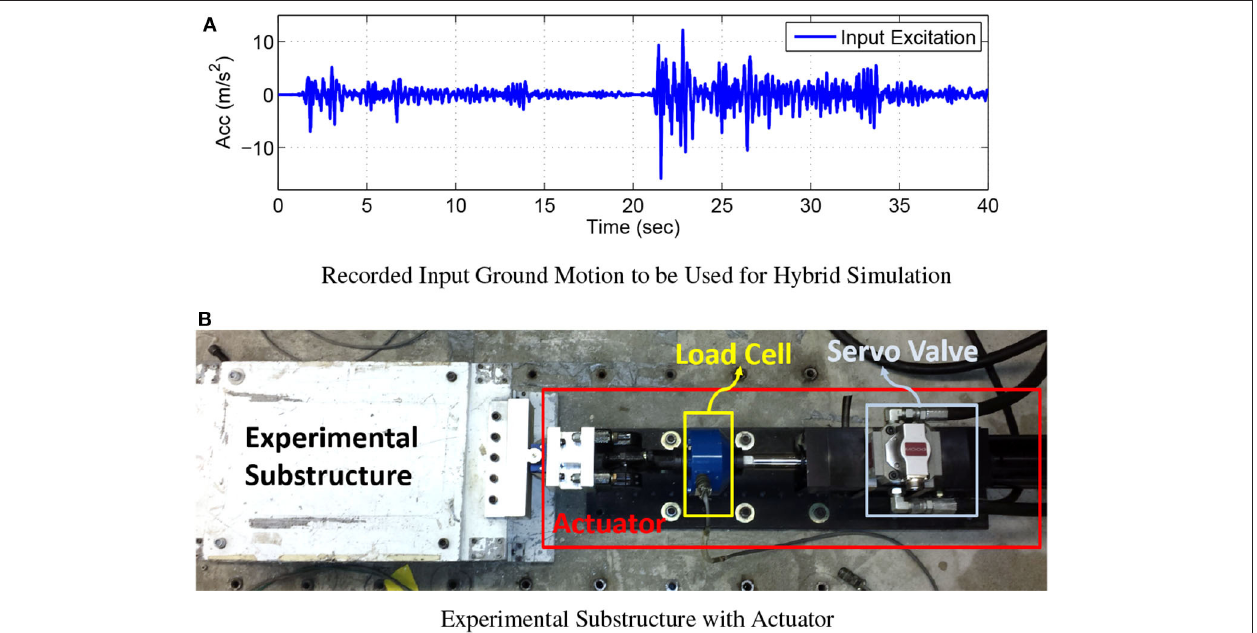
FIGURE 3 | Testing ground motion and experimental substructure setup. (A) Recorded input ground motion to be used for hybrid simulation. (B) Experimental substructure with actuator.